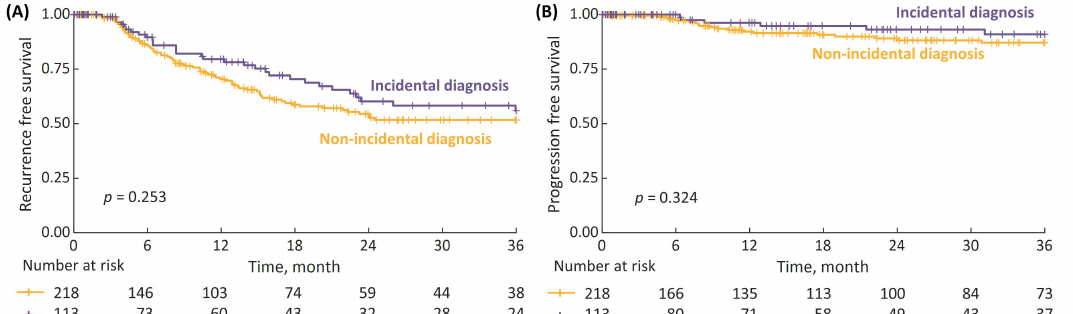
Figure 6. ( A ) 3-year recurrence-free survival (RFS) in non-muscle-invasive bladder cancer (NMIBC) patients stratified by type of diagnosis (incidental vs. non-incidental); and ( B ) 3-year progression-free survival